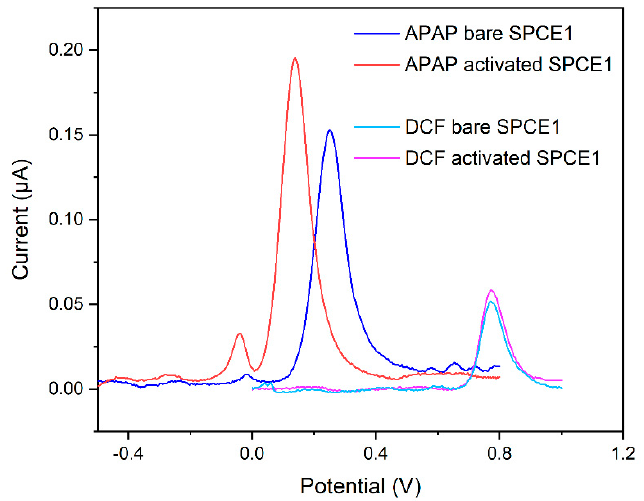
Figure 1. DPV signals of acetaminophen (APAP) and DCF obtained by non-activated and activated SPCE1. DPV signals of 11.5 mg L − 1 acetaminophen in 4.5·10 − 2 mol L − 1 PB, pH 5.0, E vs. Ag/AgCl, E pulse 100 mV, t pulse 20 ms, E step 4 mV, scan rate 5 mV/s. DPV signals of 4.0 mg L − 1 DCF in 4.5·10 − 2 mol L − 1 PB, pH 2.0, E vs. Ag/AgCl; E pulse 55 mV; t pulse 25 ms; E step 5 mV; scan rate 10 mV/s.